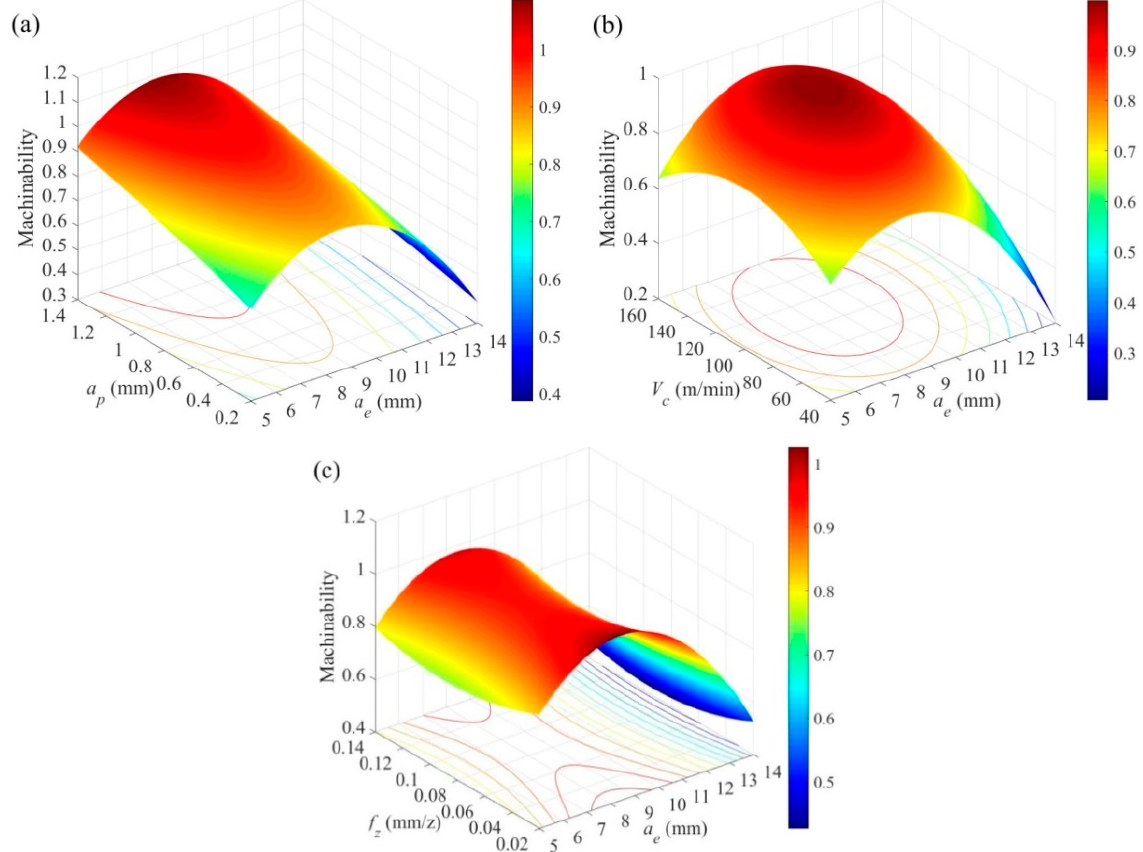
Figure 15. The interaction of ( a ) a e × a p ( V c = 80 m/min, f z = 0.06 mm/z), ( b ) a e × V c ( a p = 0.6 mm, f z = 0.06 mm/z), and ( c ) a e × f z ( V c = 80 m/min, a p = 0.6 mm) on the comprehensive machinability.